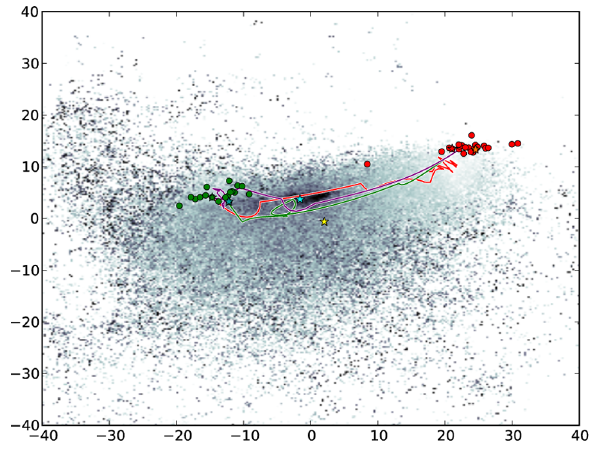
Figure 7. PCA landscape of all conformations generated in the MBP experiments. Each point represents a unique conformation. The color indicates energy with darker colors representing more energet- ically stable states. The red path shows the path found with the default schema, starting from the open state with the bound state as the goal. The green path represents the reverse case, with the default schema, starting at the bound state and moving toward the open state. The purple path was produced using the expert- schema, moving from the bound state towards the open state. The yellow star indicates the position of a known NMR structure ( PDB :2H25) of the semi-closed state. The aqua star indicates the centroid conformation of the energetic valley between the open and bound states and falls extremely close to all paths, as well as the NMR structure. The circular pattern in the green path was automatically generated and seems to arise from a slight bending reversal that occurs near the semi-closed state.